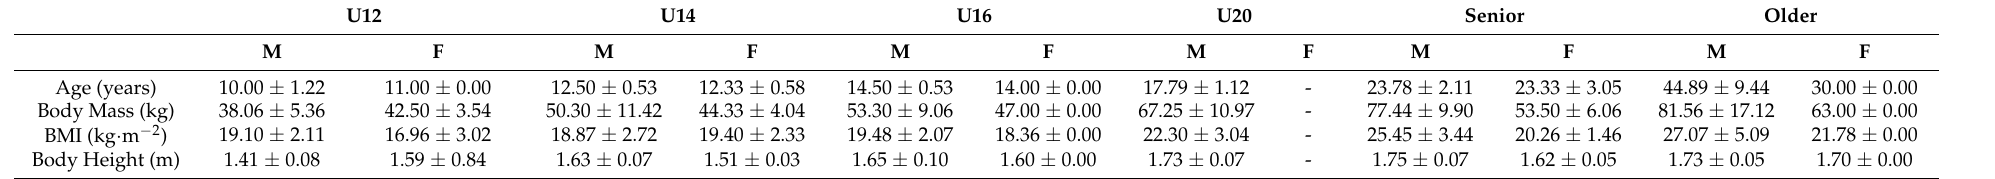
Table 1. Table tennis players’ general characteristics depending on the age group and gender (mean ±